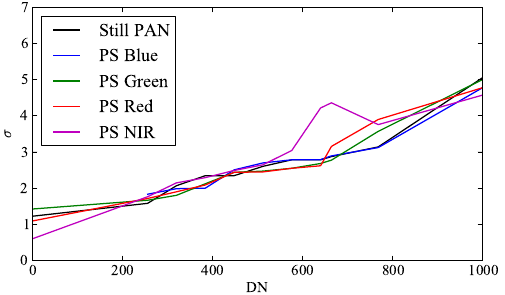
Figure 5: Noise level versus DN of panchromatic and pansharp- ened image channels. The plot shows a linear relationship be- tween noise and DN values.